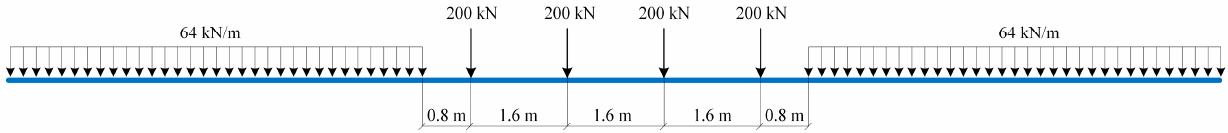
Figure 10. Graphical representation of the ZK live load.